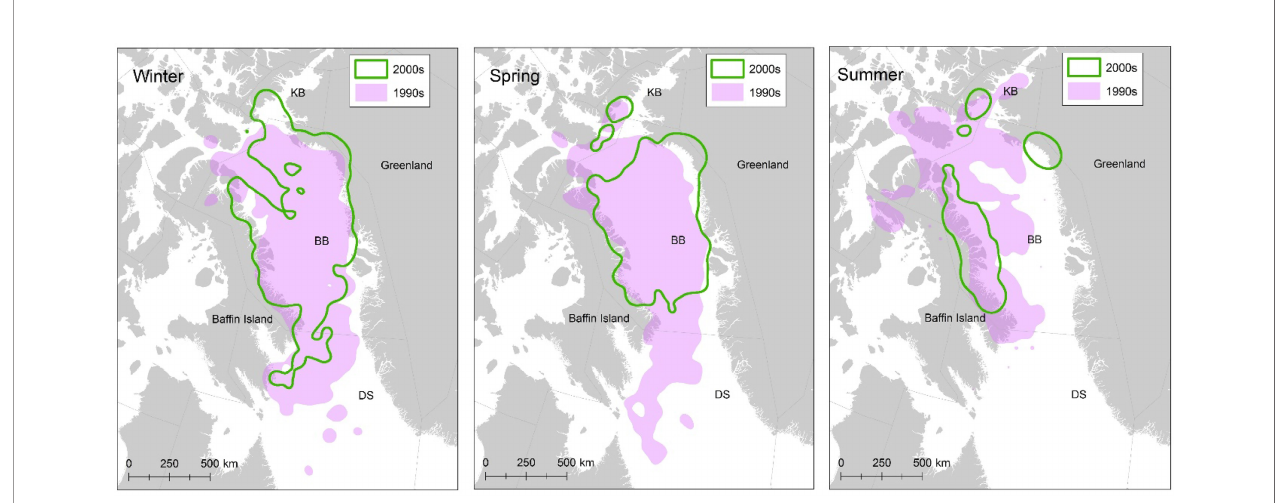
FIGURE 10 | Satellite telemetry data allow for identifying shifts in polar bear space use over time and have proven critical to interpreting data collected during population assessments (e.g., Laidre et al., 2020a). These data from the Baf fi n Bay subpopulation demonstrated large shifts in seasonal space use over two